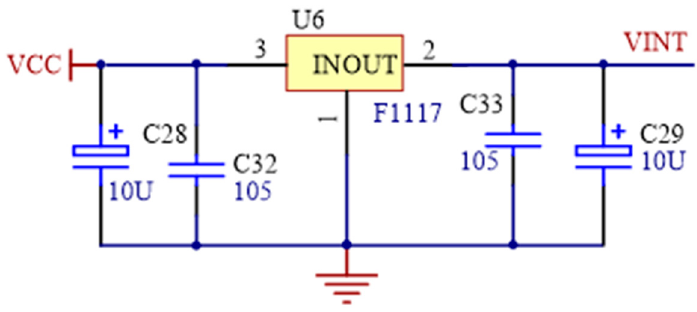
Figure 7. The schematics of power converter circuit.